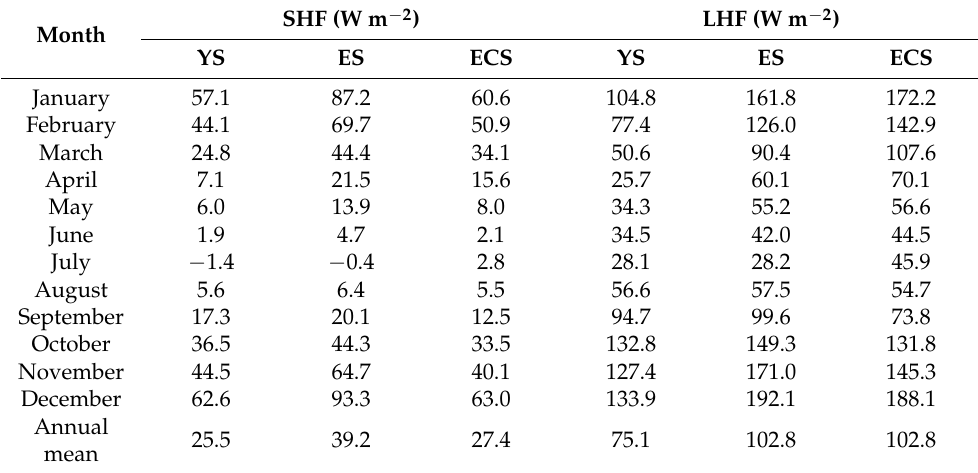
Figure 7. Monthly mean air–sea parameters (( a ) U, ( b ) T s , ( c ) T a , ( d ) Q a , ( e ) Δ T, and ( f ) Δ Q) and turbulent heat fluxes (( g ) SHF and ( h ) LHF) in the YS (black), ES (blue) and ECS (red). Vertical error bars are standard deviations for six years. Table 3. Monthly mean of SHF and LHF in the YS, ES, and ECS for the period 2014–2019.